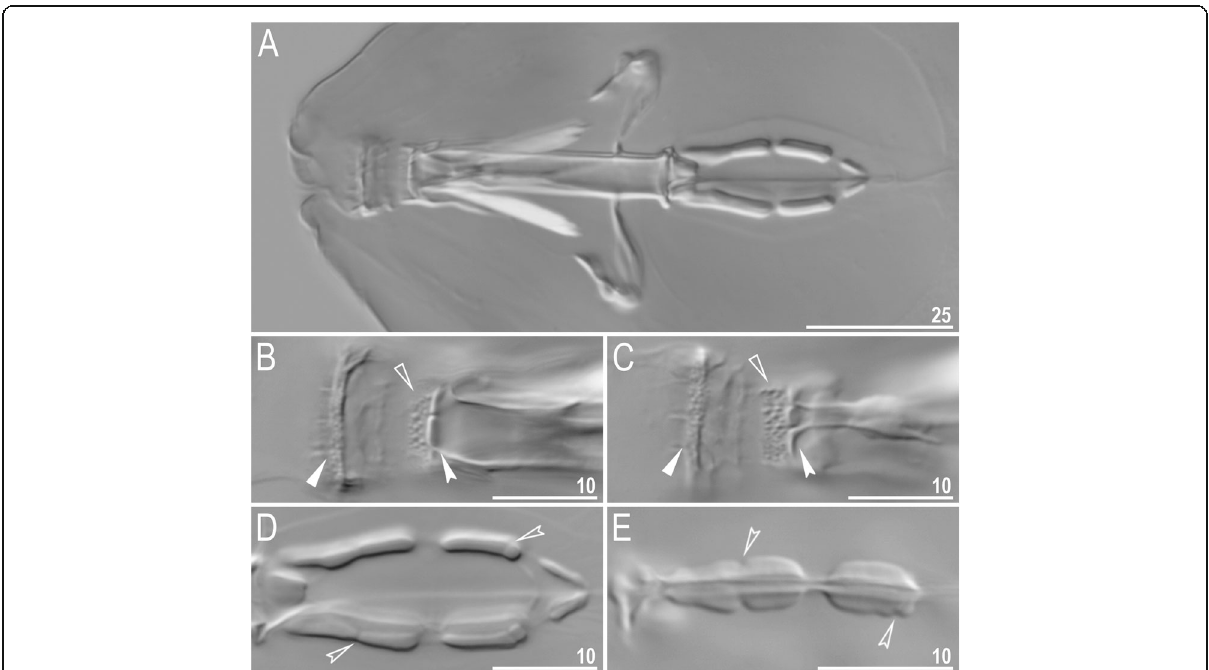
Fig. 16 Macrobiotus pseudopallarii sp. nov. from Montenegro (ME.007) – buccal apparatus seen with LCM: a – an entire buccal apparatus; b – c – the oral cavity armature, dorsal and ventral teeth, respectively; d – e – placoid morphology, dorsal and ventral placoids, respectively. Filled flat arrowheads indicate the first band of teeth, empty flat arrowheads indicate the second band of teeth, filled indented arrowheads indicate the third band of teeth and empty indented arrowheads indicate central and subterminal constrictions in the first and second macroplacoid. Scale